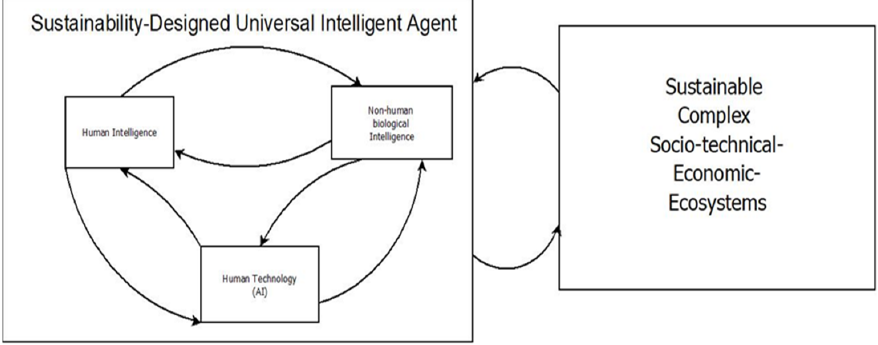
Figure 3. Sustainability-designed Universal Intelligent Agent (SUIA) for complex socio-technical- economic ecosystems.